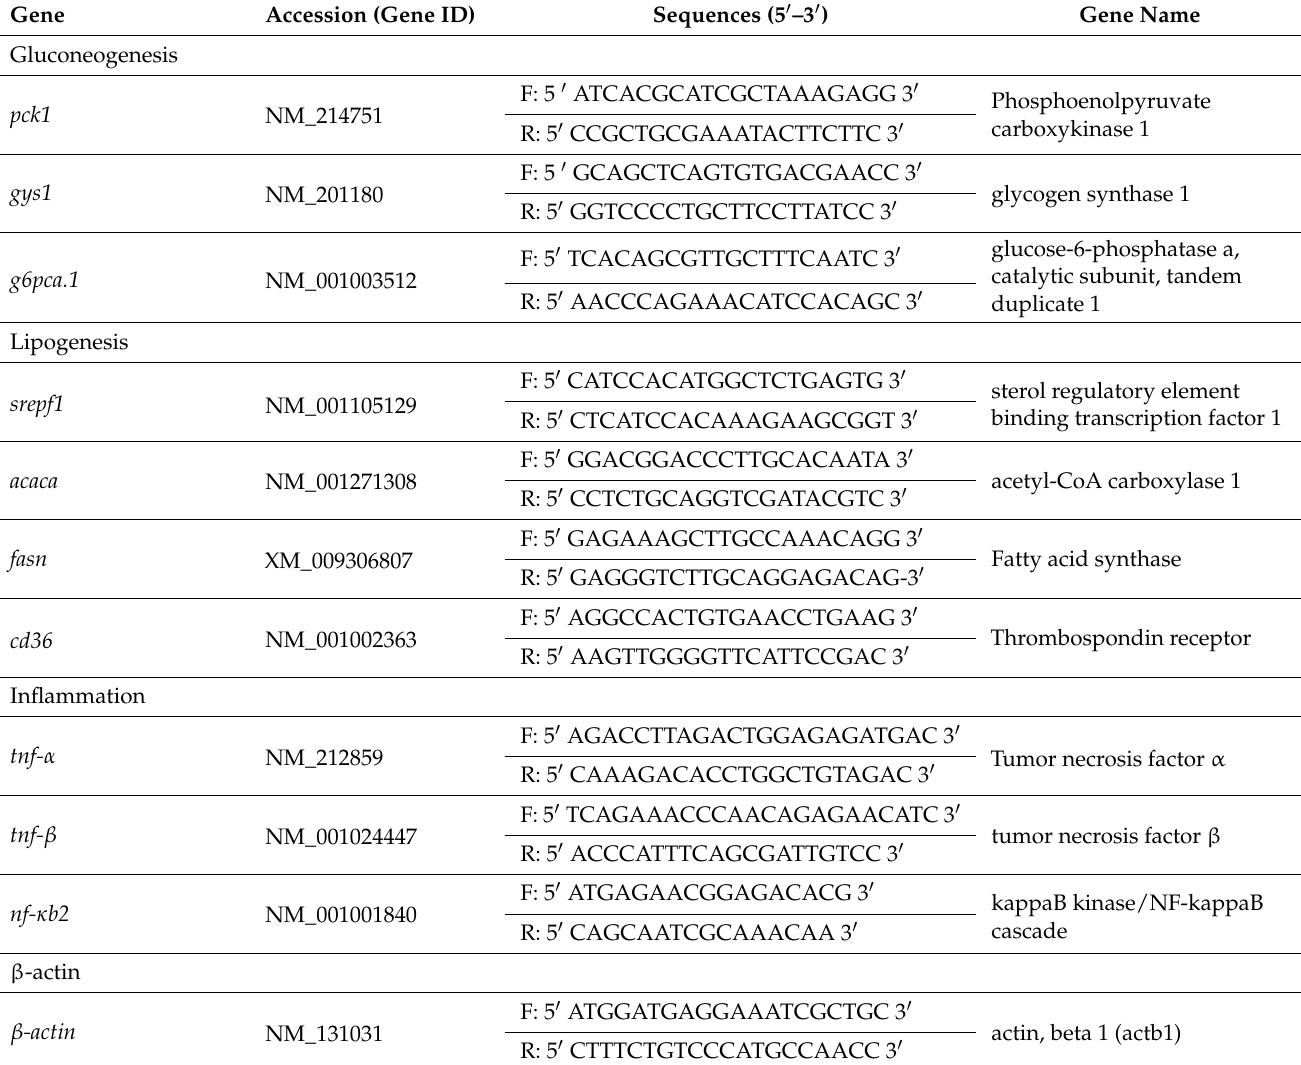
Table 1. Primer sequences (forward and reverse) used for real-time qPCR